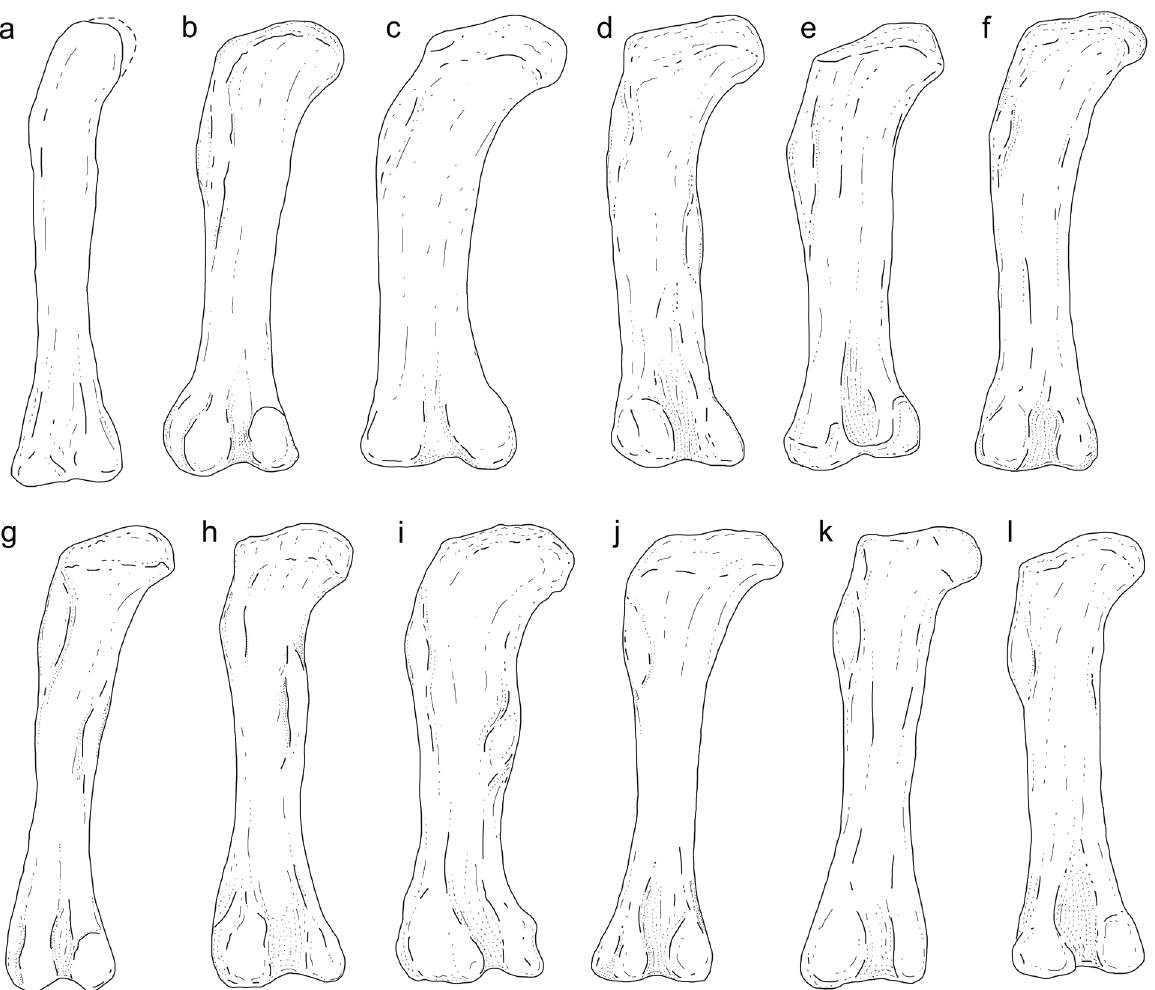
Figure 7 – Morphological comparison of South American titanosaur femora. ( a ) right femur in anterior view of Atacamatitan chilensis , SGO-PV-961g, redrawn from Kellner et al. (2011), ( b ) left femur in posterior view of Neuquensaurus australis , MLP- CS 1118, redrawn from Otero (2010), ( c ) right femur in anterior view of ‘ Neuquensaurus robustus ,’ MCS-9, redrawn from Otero (2010), ( d ) right femur in posterior view (reversed) of Epachthosaurus sciuttoi , UNPSJB-PV 920, redrawn from Martínez et al. (2004), ( e ) right femur in posterior view of Saltasaurus loricatus , PVL 4017-79, redrawn from Powell (1992), ( f ) left femur in posterior view of Petrobrasaurus puestohernandezi , MAU-PV-Ph 449/8, redrawn from Filippi et al. (2011b), ( g ) left femur in posterior view of Mendozasaurus neguyelap , IANIGLA-PV 073/4, redrawn from González riga et al. (2018), ( h ) right femur in posterior view (reversed) of Patagotitan mayorum , MPEF-PV 4400/26, redrawn from Carballido et al. (2017), ( i ) left femur in posterior view of Dreadnoughtus schrani , MPM-PV 1156, redrawn from Ullmann and Lacovara (2016), ( j ) right femur in posterior view (reversed) of ‘ Antarctosaurus ’ giganteus , drawn from unpublished photo by L.D.O.D., ( k ) left femur in posterior view of Bonatitan reigi , MACN-PV rN 821, redrawn from Salgado et al. (2015), ( j ) left femur in anterior view (reversed) of Traukutitan eocaudata , MUCPv-204, redrawn from Juárez Valieri and Calvo (2011). Not to